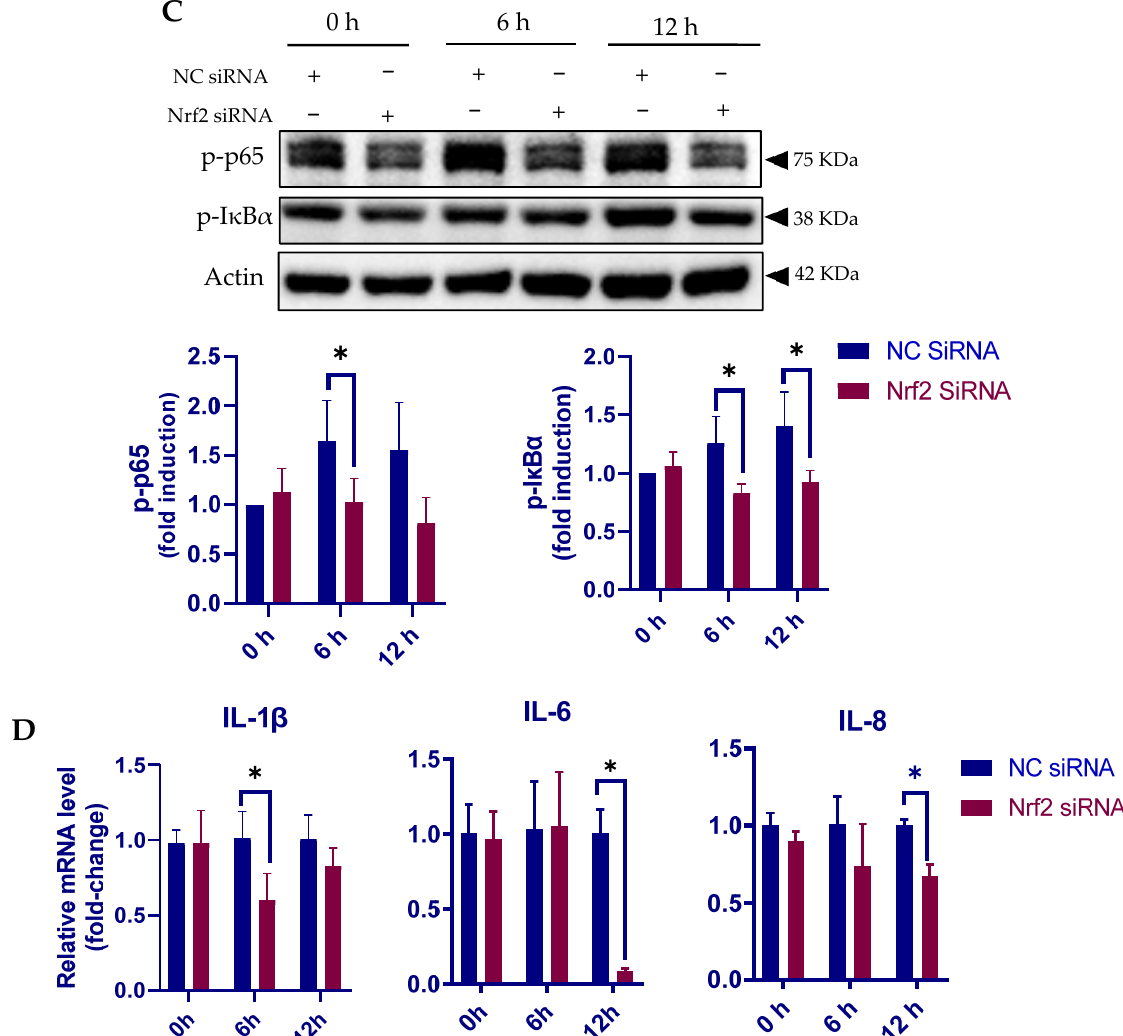
Figure 6. Nrf2 knockout attenuates LPS-induced inflammatory response in pbMECs. Cells were transfected with siRNA targeting Nrf2 or a negative control (NC) siRNA for 48 h, and the efficiency of Nrf2 knockdown was confirmed by RT-qPCR (left panel) and Western blotting (right panel). β -actin was used for the equal loading control ( A ). The cells were then incubated with LPS (10 μ g/mL) for the indicated time. Cell viability was determined by MTT assay. The results are the mean ± s.d. of six replicates ( B ). The cells were then lysed with RIPA lysis buffer and subjected to immunoblot analysis against Nrf2, phosphor-I κ B α (p-I κ B α ) and NF- κ B p65 (p-p65) by using anti-Nrf2, anti-pI κ B α , and anti-pNF- κ B p65 antibodies, respectively. β -actin was used for the equal loading control. p-p65 and p- I κ B α levels were quantified with densitometry analyses after normalization to Actin. Bars are means ± s.d. of three triplicates and are representative of 3 separate experiments ( C ). Total RNAs were prepared and subjected to qPCR analyses for the mRNA levels of IL-1 β , TNF- α , IL-6 and IL-8 . The results are the mean ± s.d. of three replicates and are representative of 3 separate experiments ( D ). * p < 0.05.